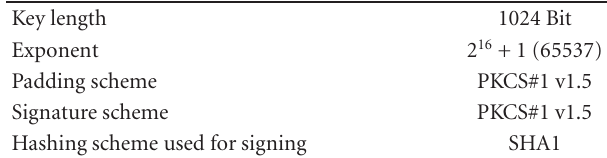
Table 5: Parameters for